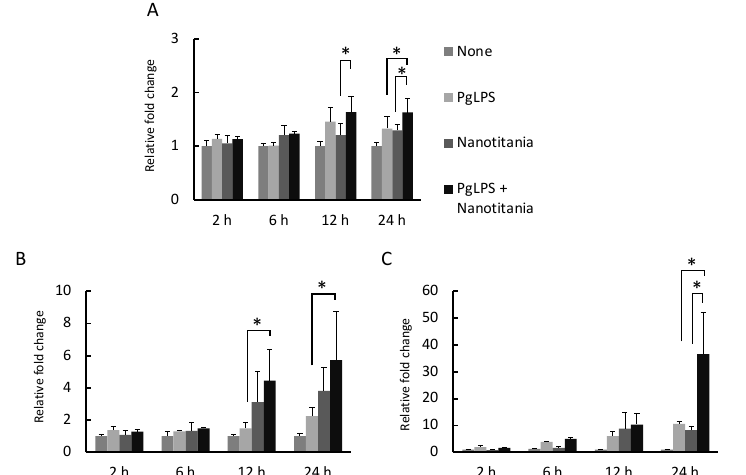
Figure 4. Expression levels of IL-1 β ( A ), IL-6 ( B ) and IL-8 ( C ) mRNA were measured by qPCR after incubation with 10 µg/mL PgLPS, 10 µg/mL nanotitania and both stimulants together. Each data point indicates the average of six gene expression quantification results (n = 6). Bars indicate standard deviation, and asterisks indicate p < 0.05.